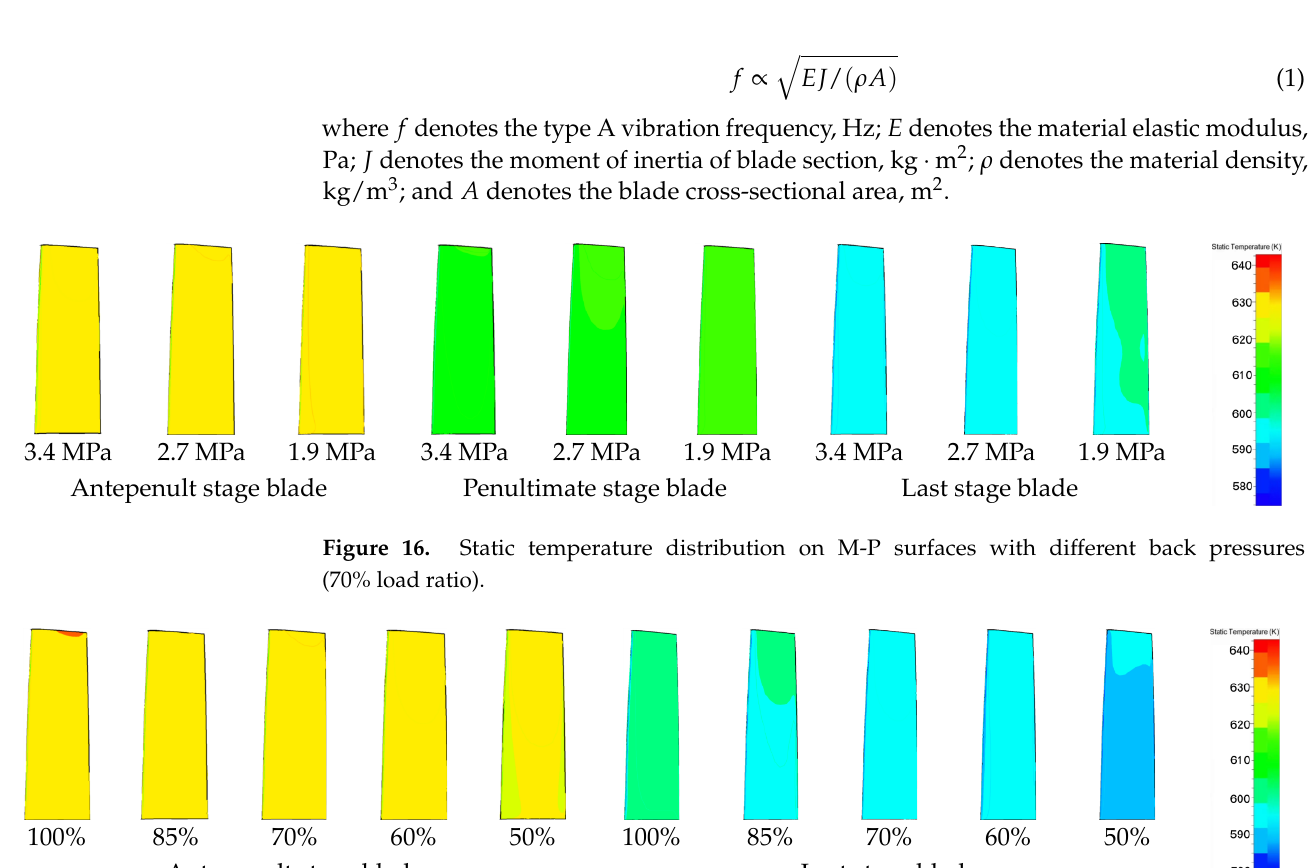
Figure 15. Amount of work performed by the last three stage blades (1.9 MPa back pressure) .